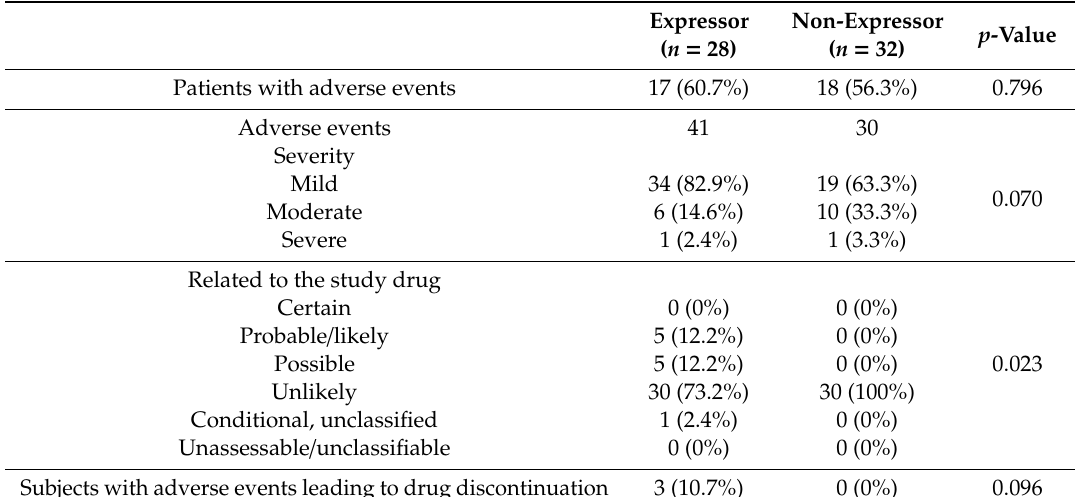
Table 4. Adverse events stratified according to CYP3A5